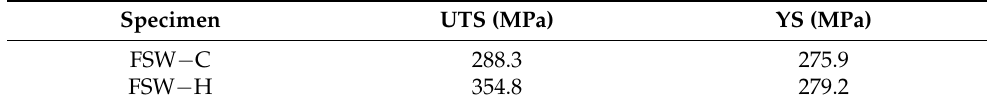
Table 3. Tensile properties of the studied joints.